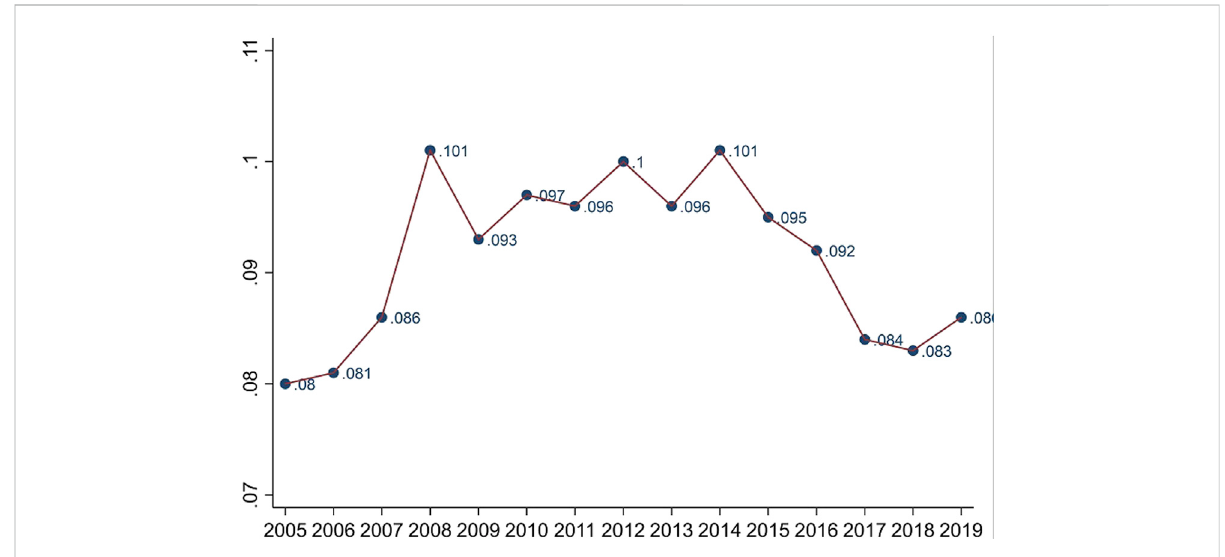
FIGURE 3 Moran I index of CO 2 emission intensity and its variation in different